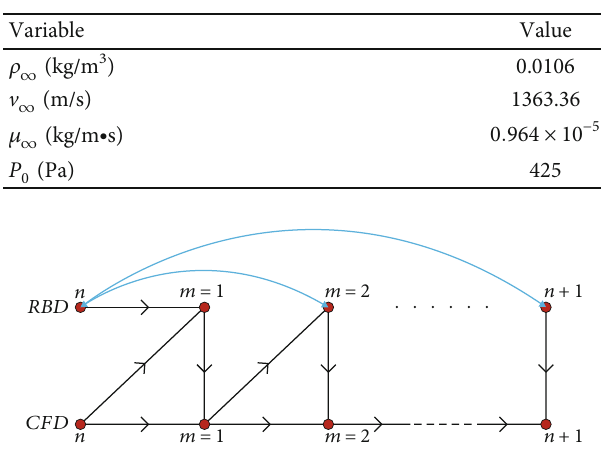
Figure 2: Data interaction scheme of the strong coupling method. CFD (computational fl uid dynamics) represents the solution of the Navier-Stokes equation, while RBD (rigid body dynamics) denotes the computation of fl ight dynamics and kinematics